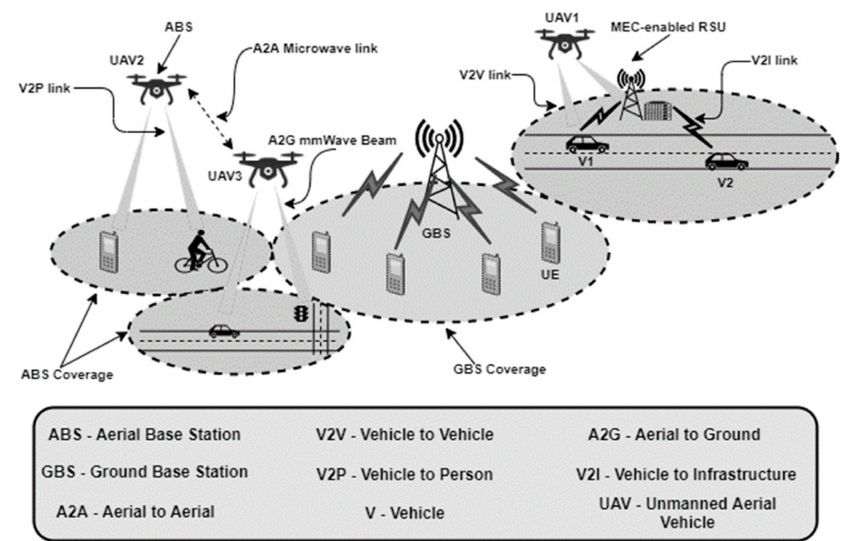
Figure 7. An example of the 5G-enabled drone